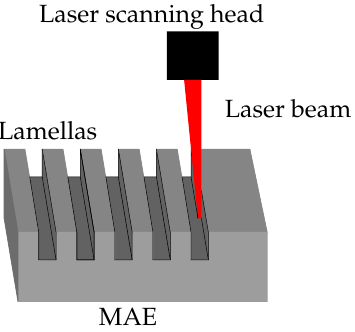
Figure 4. Schematic presentation of direct laser structuring.